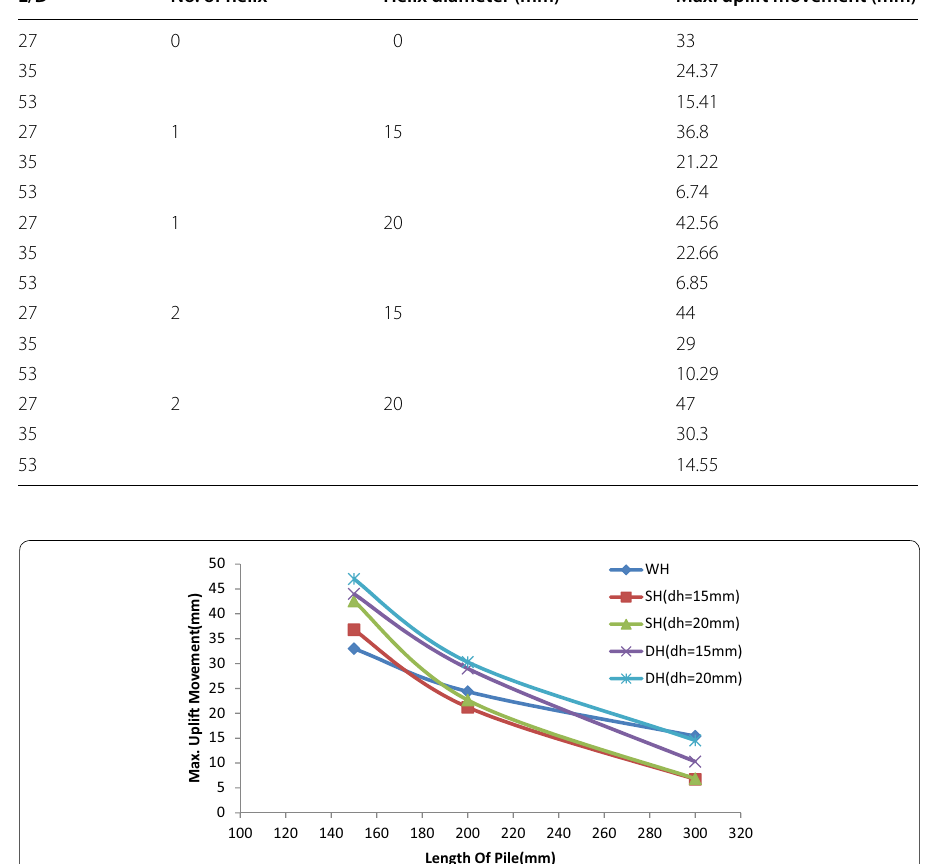
Fig. 10 Variation of maximum uplift movement of helical pile with different lengths and helix diameters